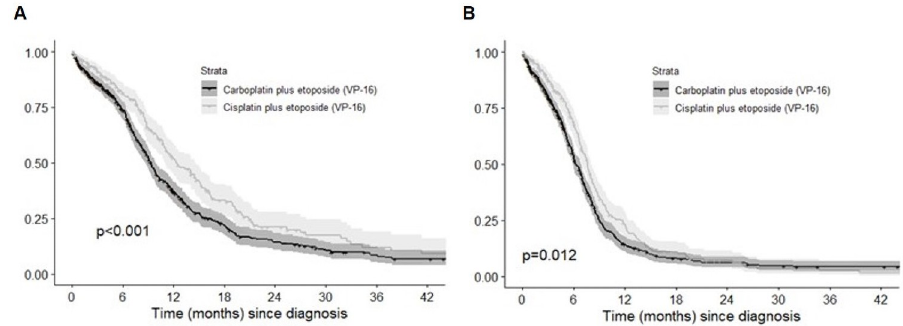
Fig 2. Overall survival (A) and progression-free survival (B) in patients treated with first-line carboplatin/ cisplatin + etoposide VP16.